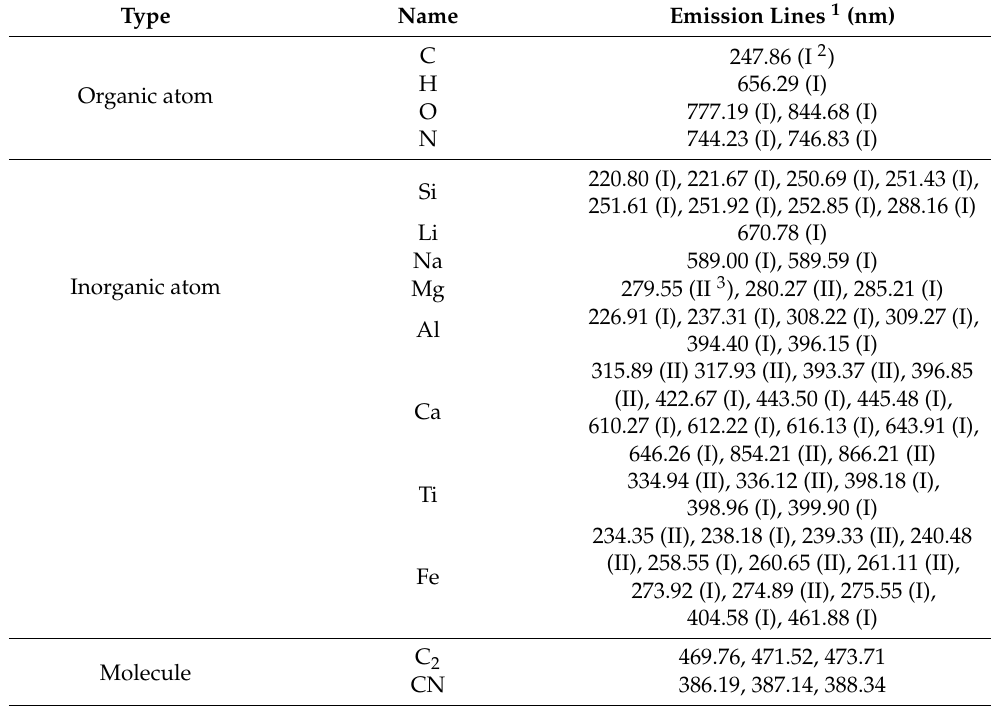
Table 2. Emission lines related to coal proximate